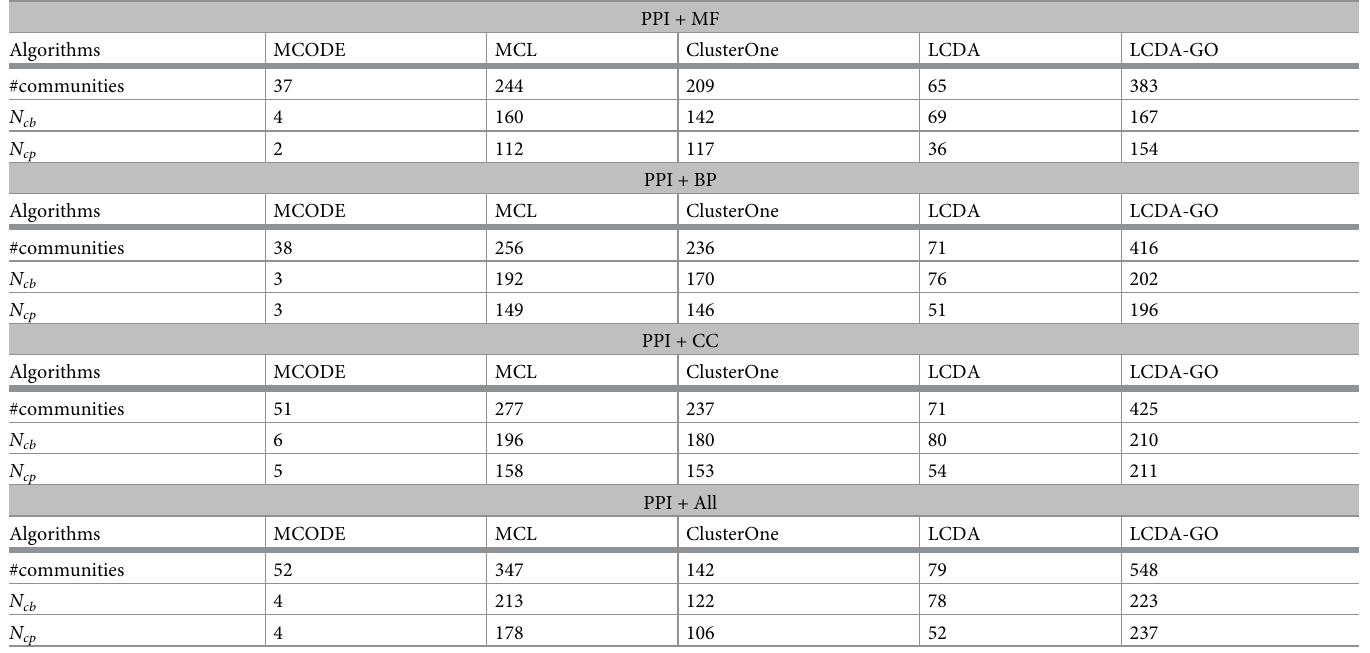
Table 3. An overview of the resulted communities from each algorithm including our method on Saccharomyces Cerevisiae Krogan interaction